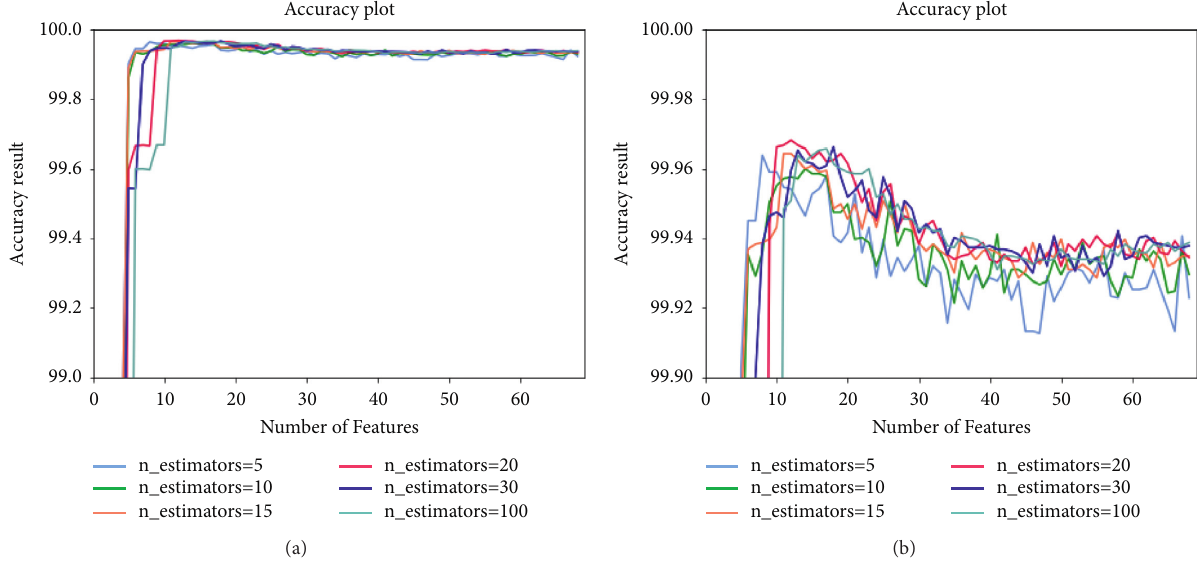
Figure 4: Accuracy score on CICIDS2017-Wed1 dataset with RFE. (a) Accuracy score above 99%. (b) Accuracy score above 99.9%. Accuracy plot